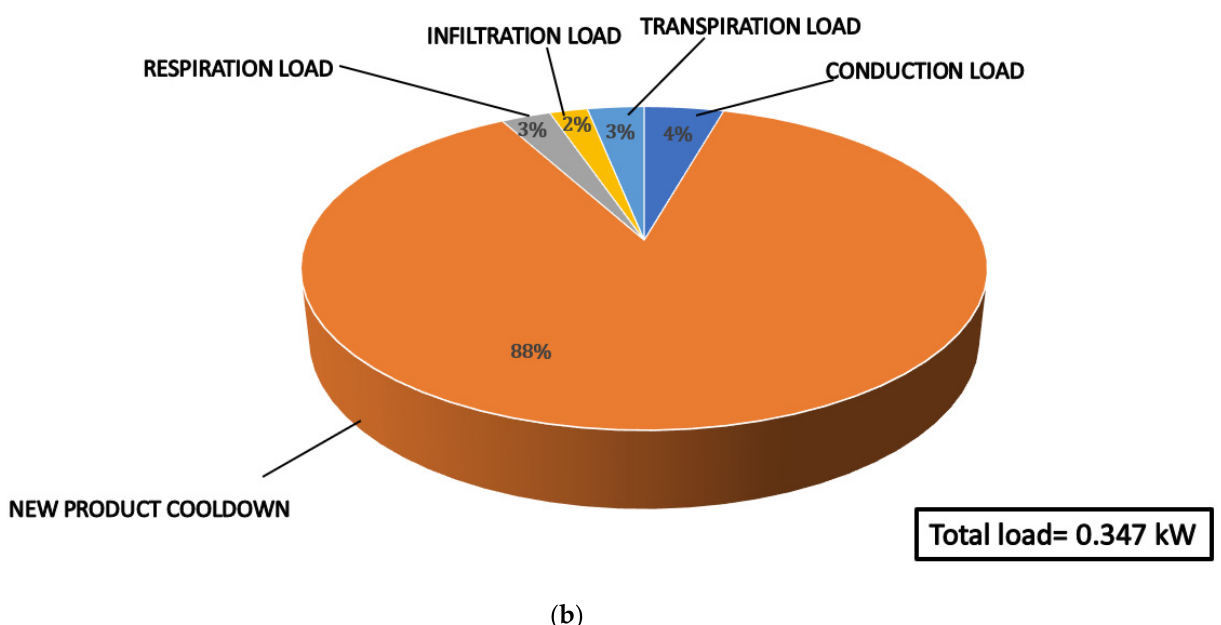
Figure 5. Representative heat load for a single mini container (MC) containing tomatoes in: ( a ) Phoenix, and ( b ) Chicago.